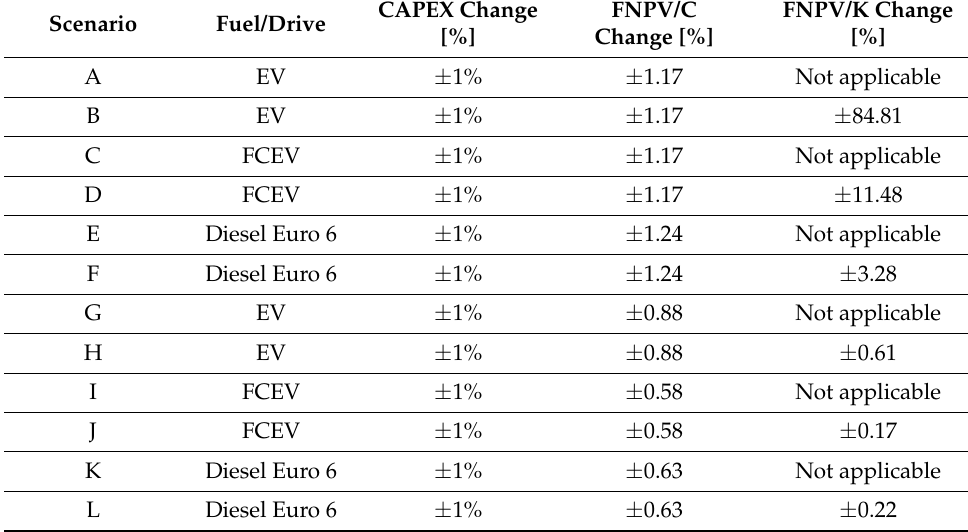
Table 6. Sensitivity analysis for FNPV/C, FNPV/K and relative changes of CAPEX.